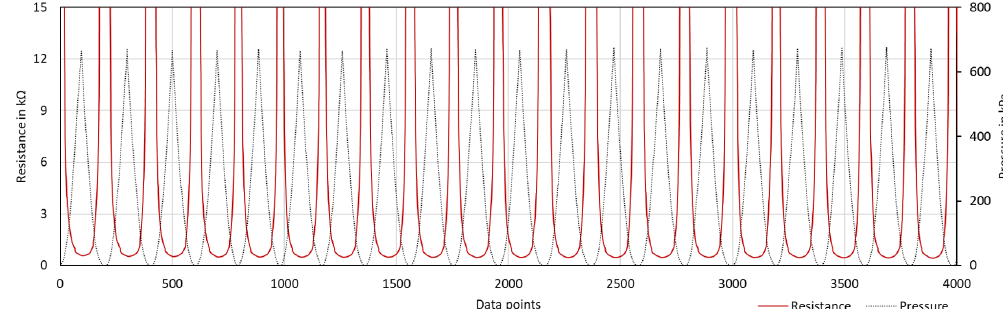
Figure 5. Cyclic test under continuous loading–unloading for 20 cycles at a rate of 2Ns − 1 .